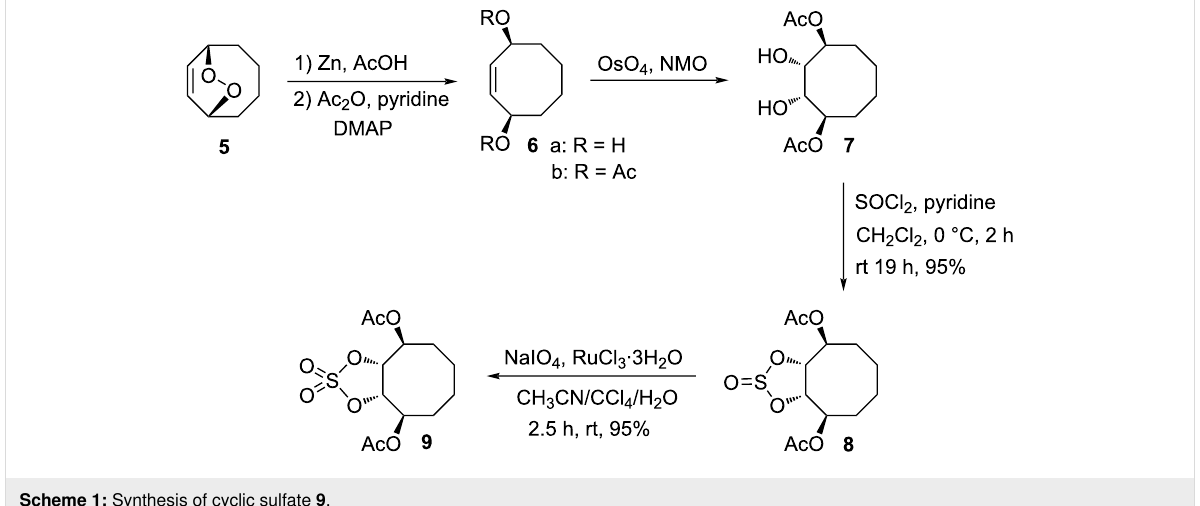
Scheme 1: Synthesis of cyclic sulfate 9 .